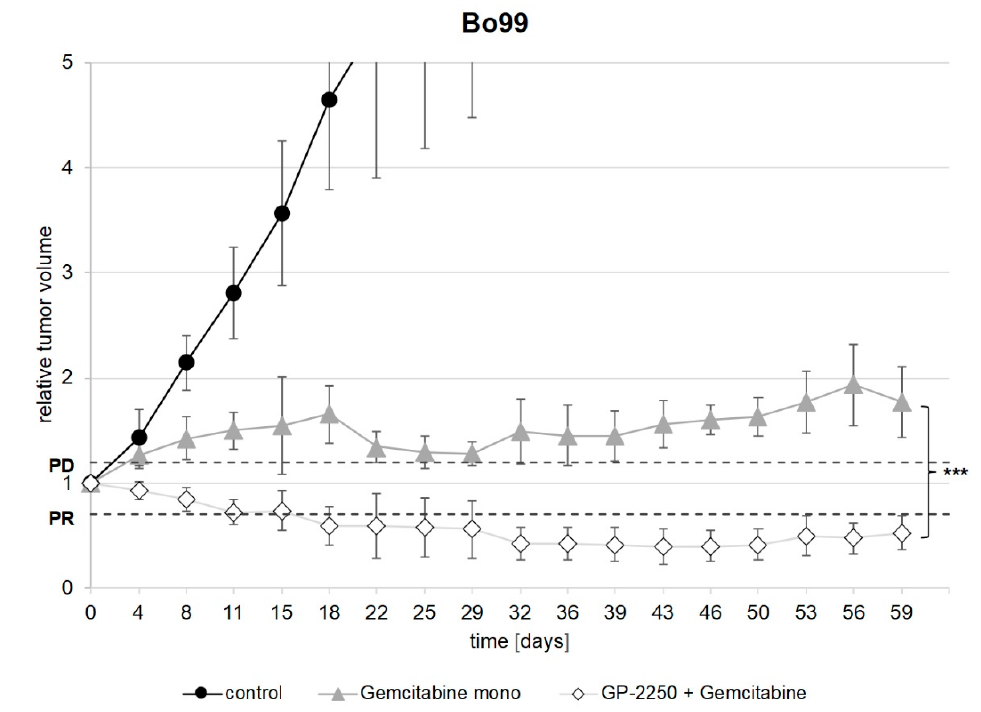
Figure 4. Development of the relative tumor volume of Bo99 during the observation period. Figure 4 shows the development of the relative tumor volume during the observation period of Bo99 tumors treated with Gemcitabine mono and a combination of Gemcitabine and GP-2250 in comparison to the untreated controls. PD, progressive disease; PR, partial response. Error bars show the standard deviation. p -values are indicated as follows: *** p ≤ 0.001.